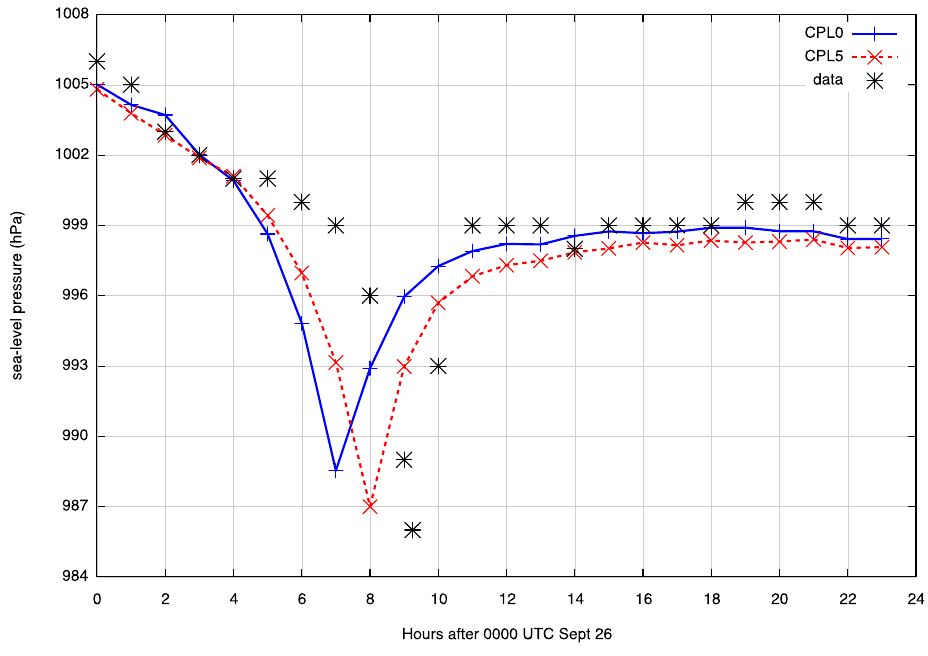
Figure 10. Time series of sea-level pressure at Nardo station for the measured data (asterisks); CPL0 run (blue continuous line); CPL5 run (red dotted line).